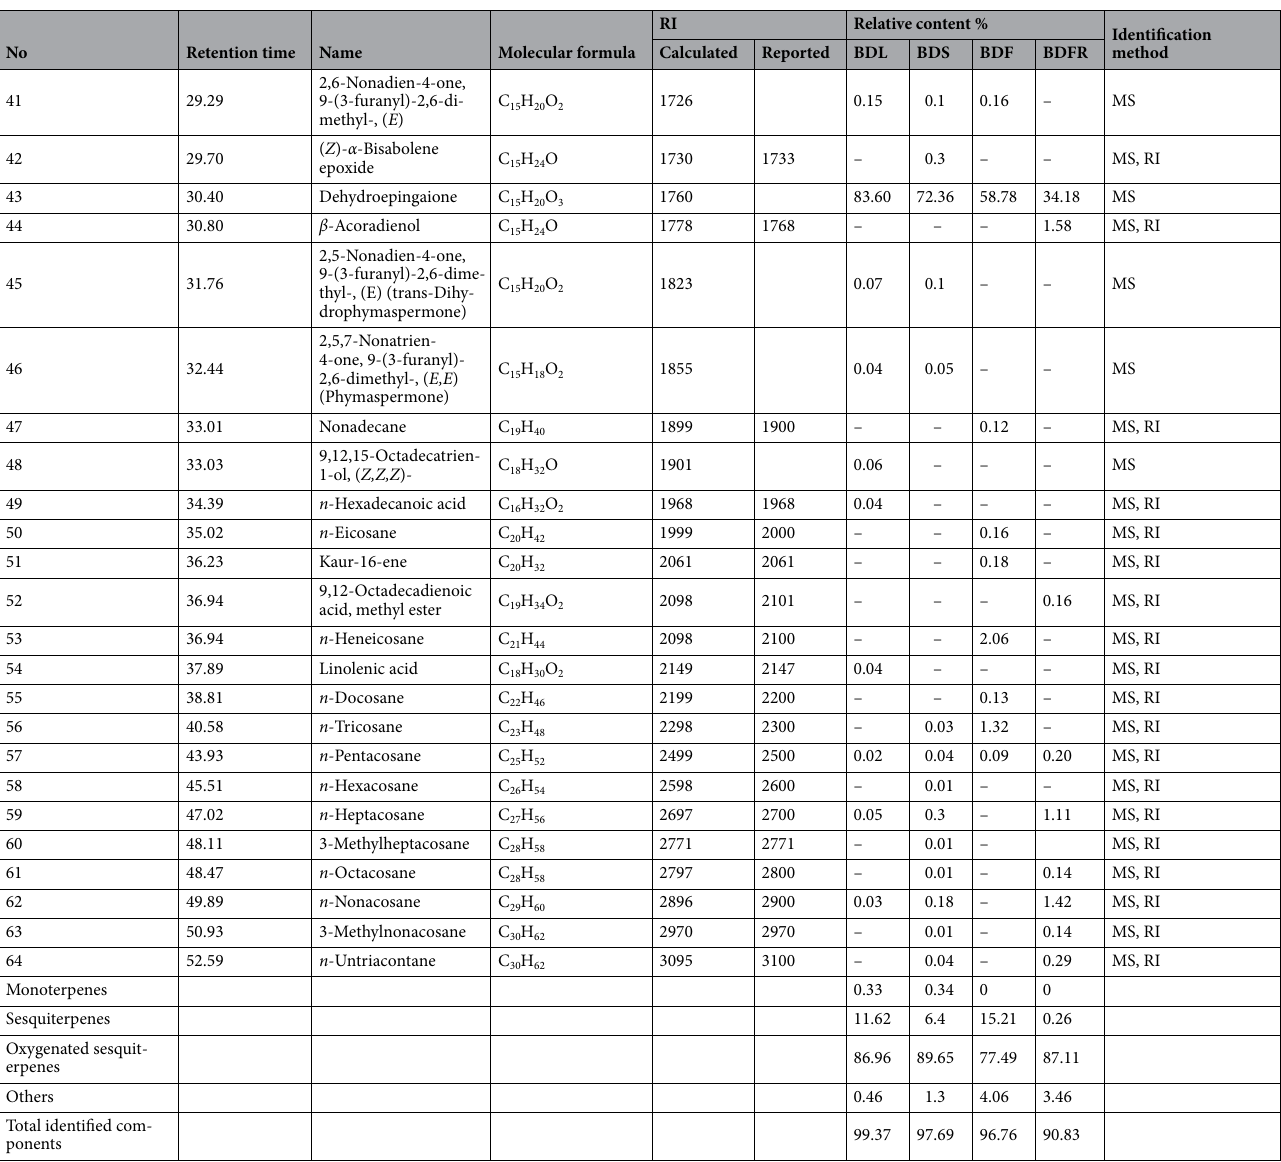
Table 1. Volatile constituents of B. daphnoides leaves (BDL), B. daphnoides stems (BDS), B. daphnoides flowers (BDF) and B. daphnoides fruits (BDFR). The names of the components are in order of their elution from the Rtx-5MS column. Identification, was based on comparison of the compounds’ mass spectral data (MS) and retention indices (RI) with those of NIST Mass Spectral Library and